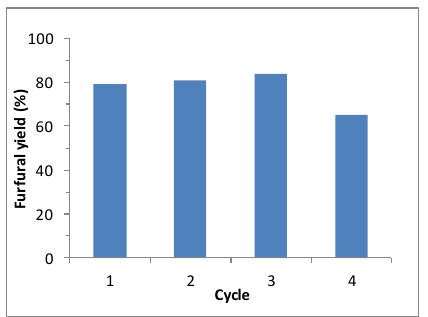
Figure 5. Reusability of the aqueous phase containing Nafion NR50 and NaCl for the D -xylose dehydration to furfural. Reaction conditions: Nafion NR50 (2 pellets), NaCl (95 mg), D -xylose (1.0 mmol), water (1 mL), CPME (3 mL), MW, 170 °C and 40 min.